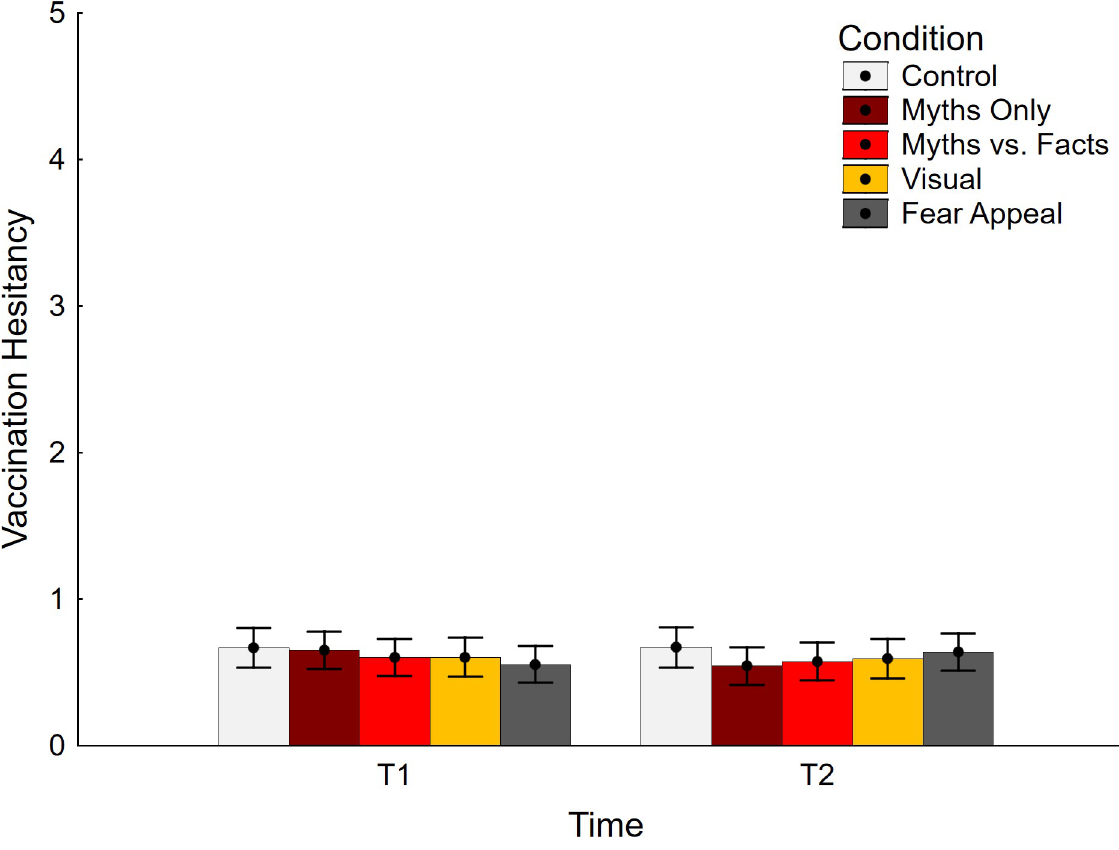
Fig 3. Vaccination hesitancy across conditions. Error bars show 95% confidence intervals.